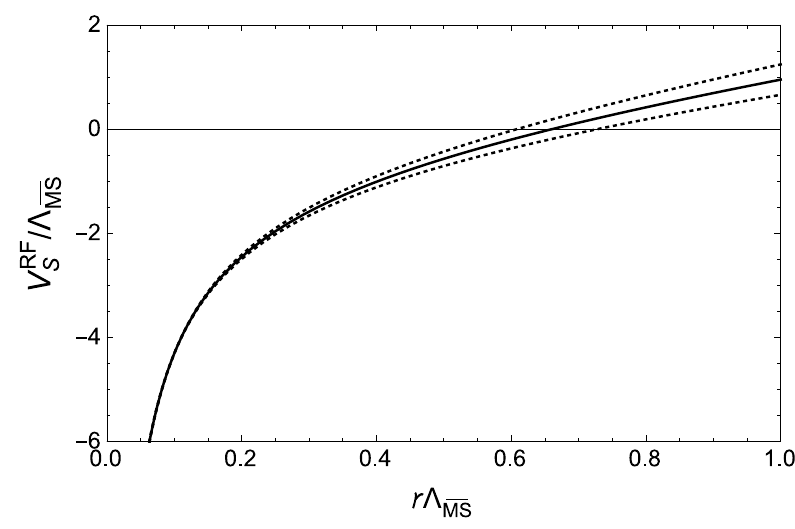
Figure 2 . V RF at N 3 LL (solid) and the higher order uncertainty given by the region between the S dotted lines. The r -independent constants are adjusted such that three lines take the same value at (cid:3) r = 0 : MS